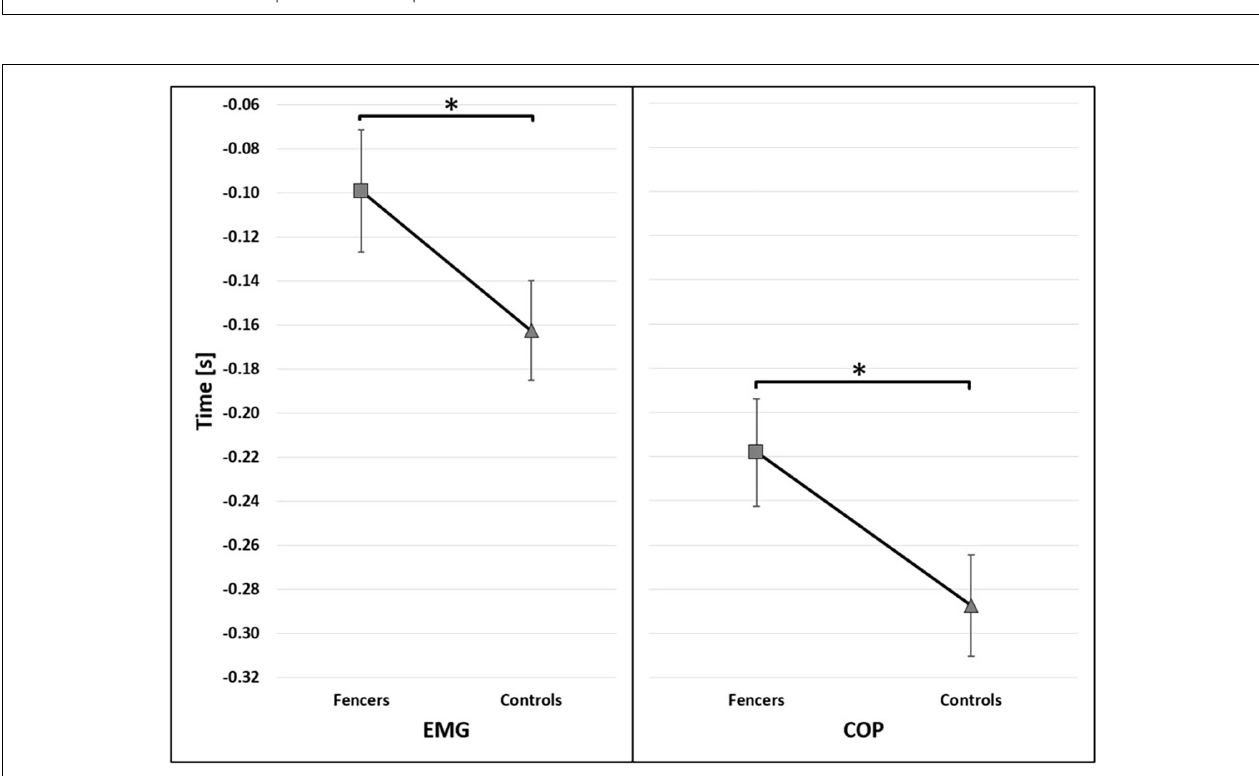
FIGURE 3 | The average time of the onset of TA activity (EMG) and COP displacement (COP) before t 0 for group factor (95% confidence interval presented as error bars). The significant differences between groups were marked as *.